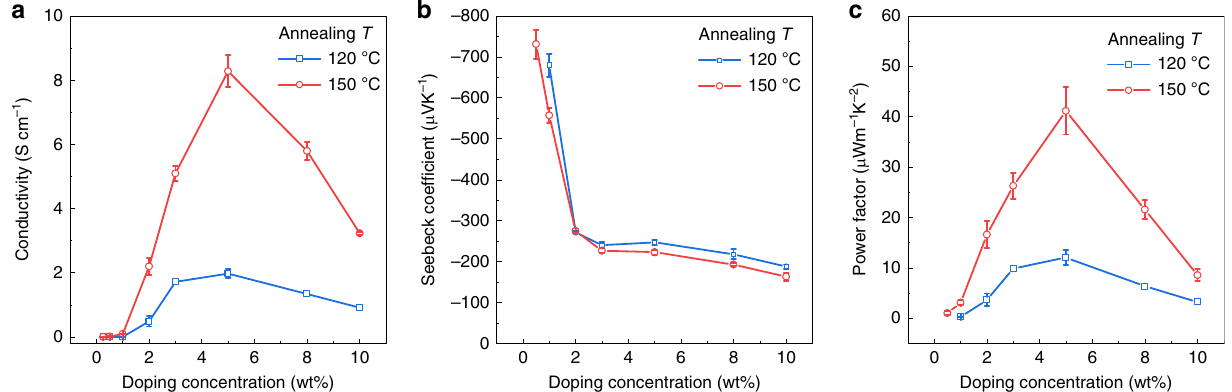
Fig. 4 Optimization of thermoelectric parameters by controlling the doping. a electrical conductivity, b Seebeck coef fi cient, and c power factor as a function of doping concentration for doped PTEG-2 fi lm at room temperature. Error bars indicate the standard errors of the mean values of electrical conductivity, Seebeck coef fi cient and power factor obtained by the measurement of six different